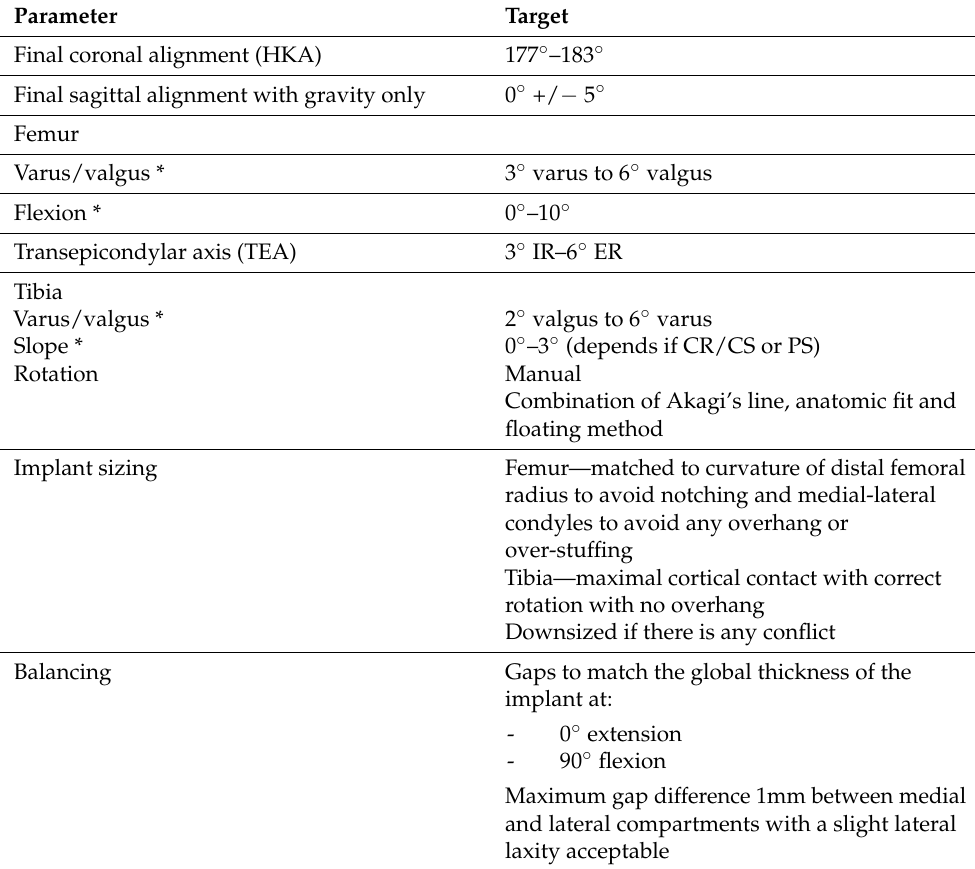
Table 1. Functional Alignment Philosophy Protocol Guidelines for the valgus morphotype.